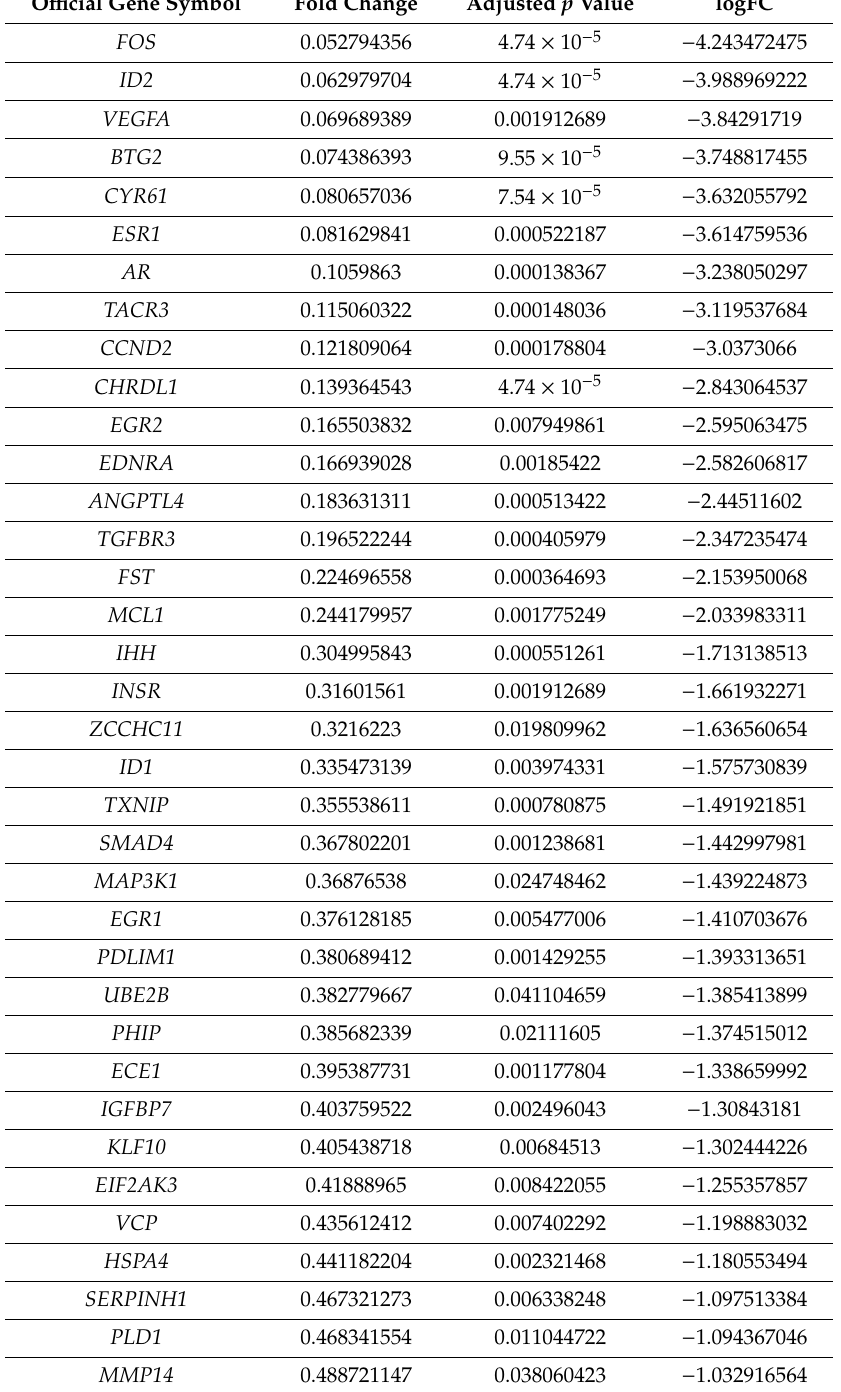
Table 1. Gene symbols, fold changes in expression, corrected p values and LogFC of studied genes. O ffi cial Gene